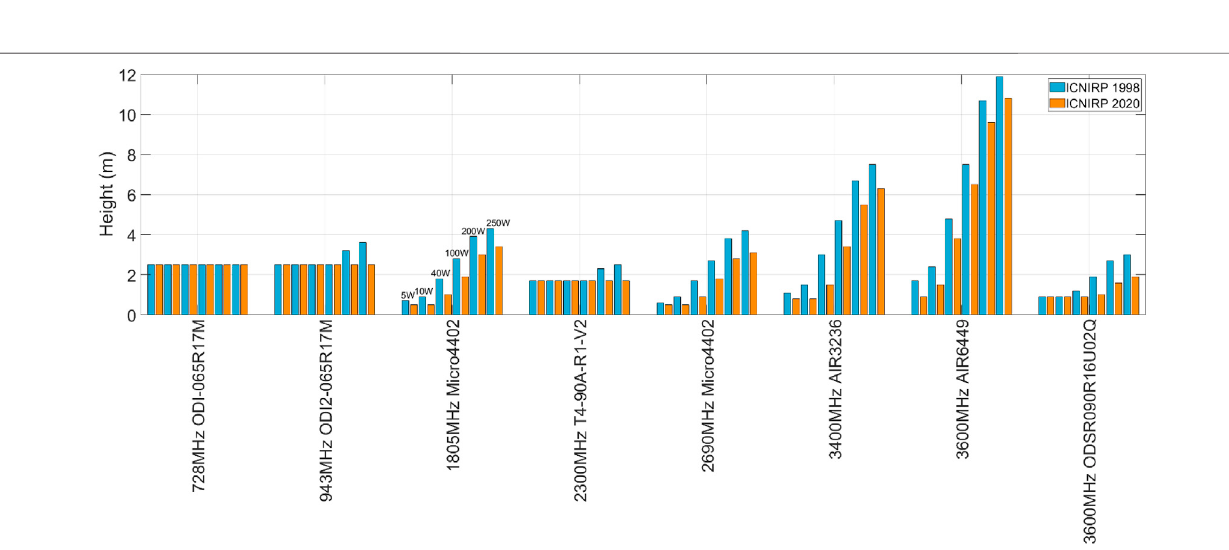
Frontiers in Communications and Networks |